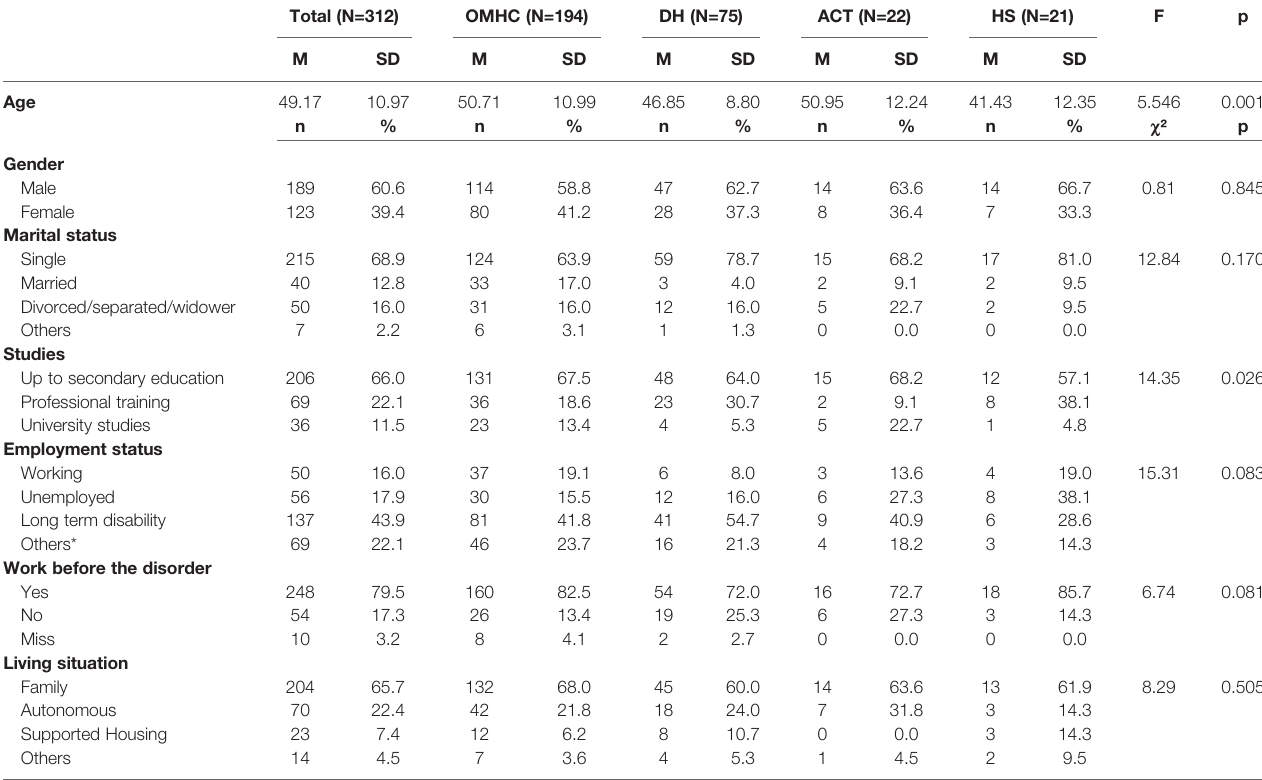
TABLE 1 | Descriptive statistics and contrast tests of the sociodemographic variables in relation to type of care center. Total